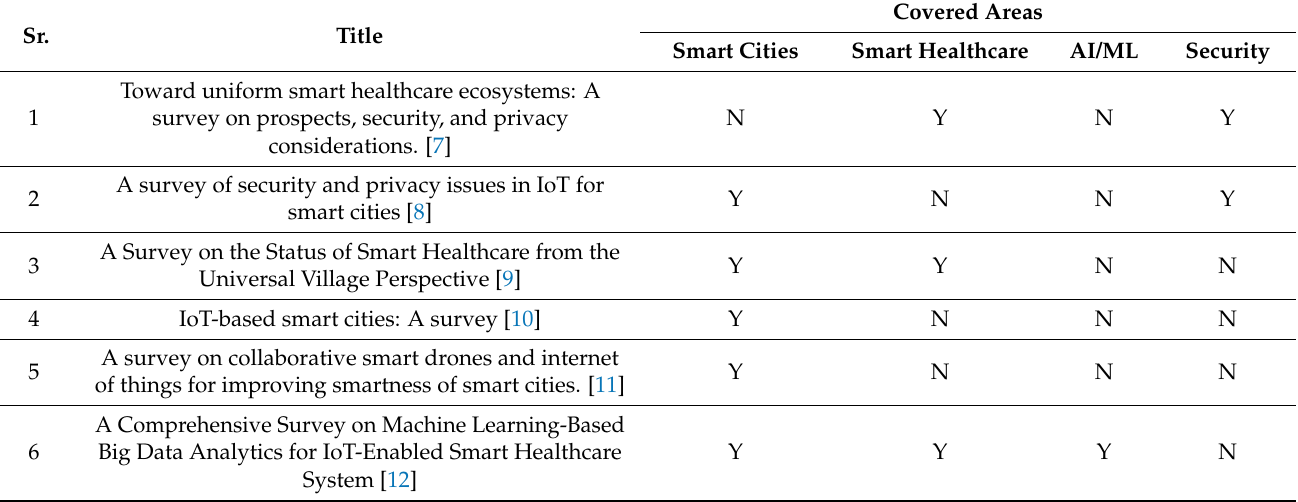
Table 1. Reviewed